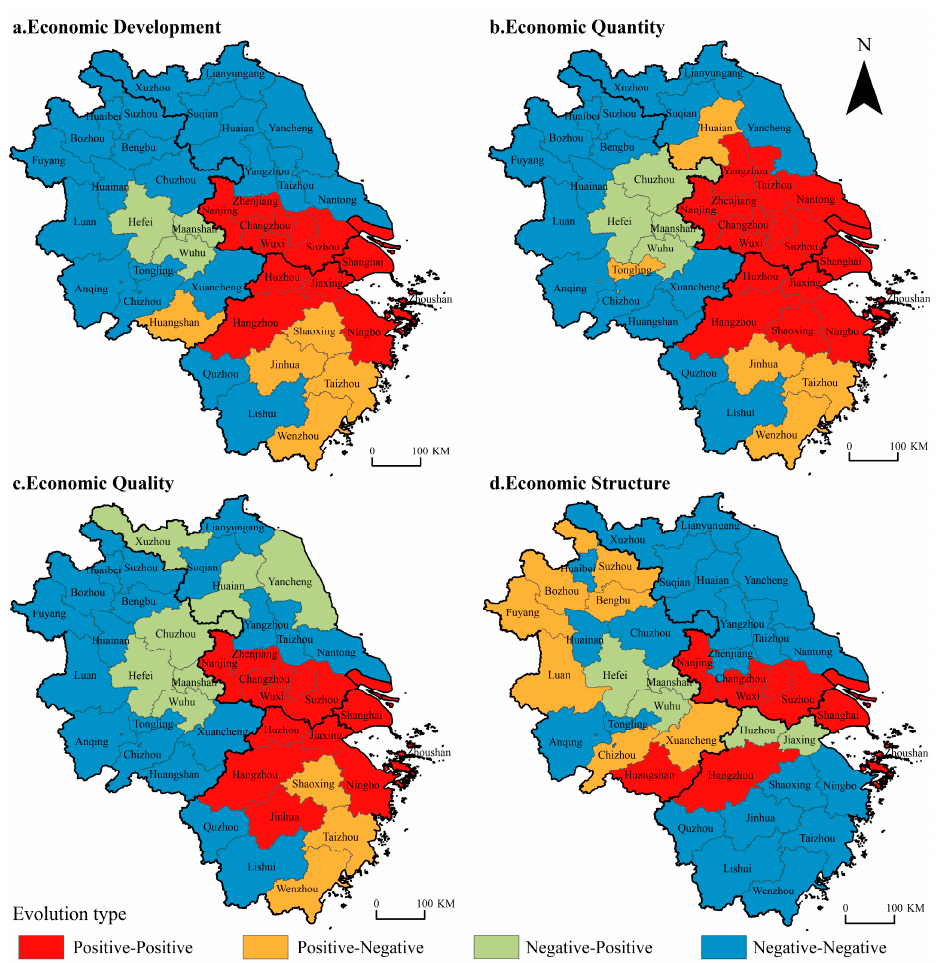
Figure 4. Evolution types of economic spatial polarization in the YRD.